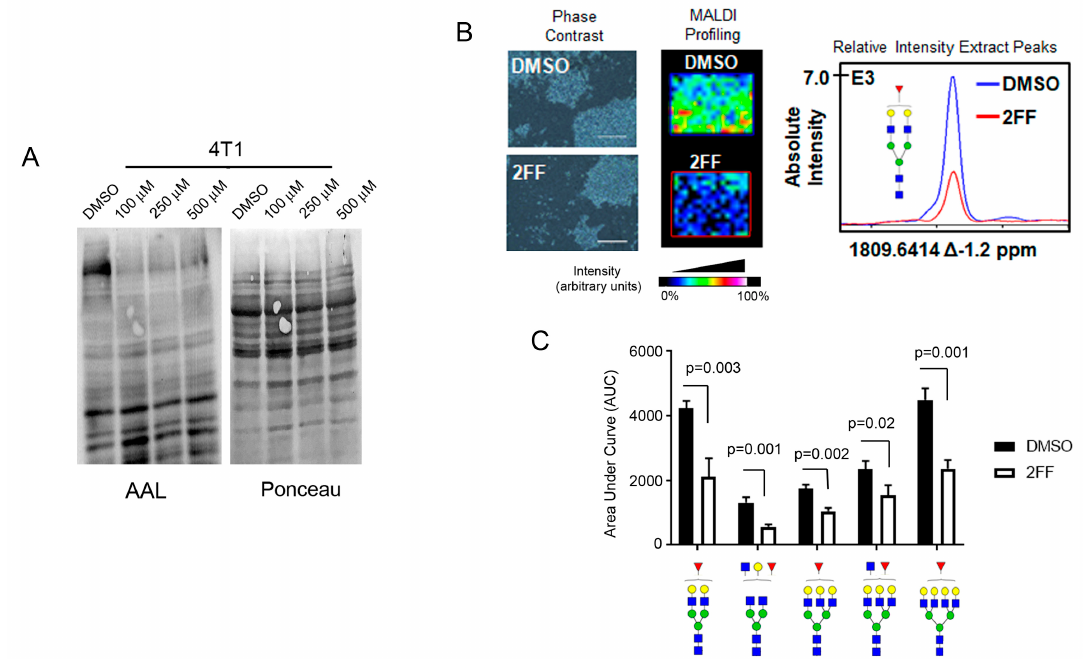
Figure 1. 2-deoxy-2-fluoro-L-fucose (2FF) suppress fucosylation in 4T1 cells. ( A ) Decreased fucose detected by Aleuria aurantia lectin (AAL) blotting of 4T1 cell lysates treated with vehicle (DMSO) or increasing concentration (100–500 µ M) of 2FF, a fucosylation inhibitor. Ponceau S stain was used to show total protein loading. ( B ) MALDI-IMS of 4T1 cells grown in tissue chambered slide and treated with DMSO or with 500 µ M 2FF. Phase contrast ( left panel) depicts cells from DMSO or 2FF chambers used in MALDI profiling experiments ( middle panel). Scale bar = 400 µ m The graph showing absolute intensity is shown ( right panel). ( C ) The area under the curve (AUC) of normalized total ion count (TIC) was calculated and compared between DMSO control and 2FF treated samples. Glycan nomenclature: Blue square as GlcNAc, yellow circle as galactose, green circle as mannose, red triangle as fucose.